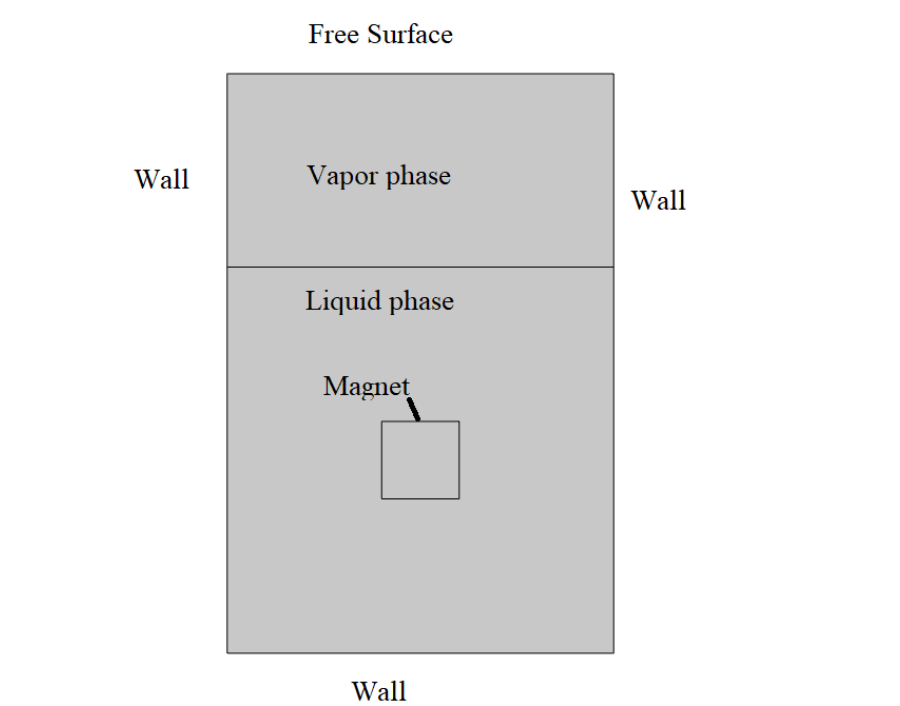
Figure 1. Schematic of the